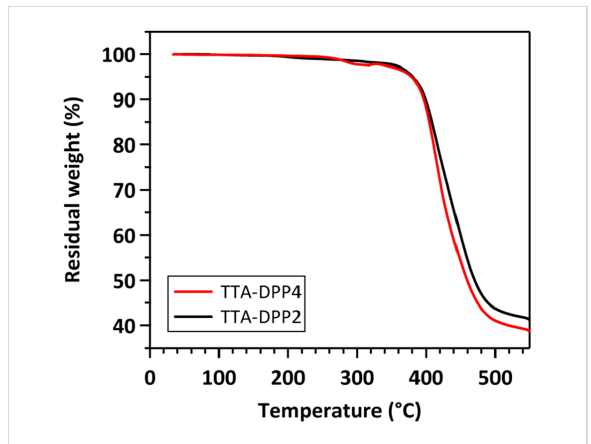
Figure 3: TGA curves of TTA-DPP4 and TTA-DPP2 at a heating rate of 10 °C min -1 under N 2 .